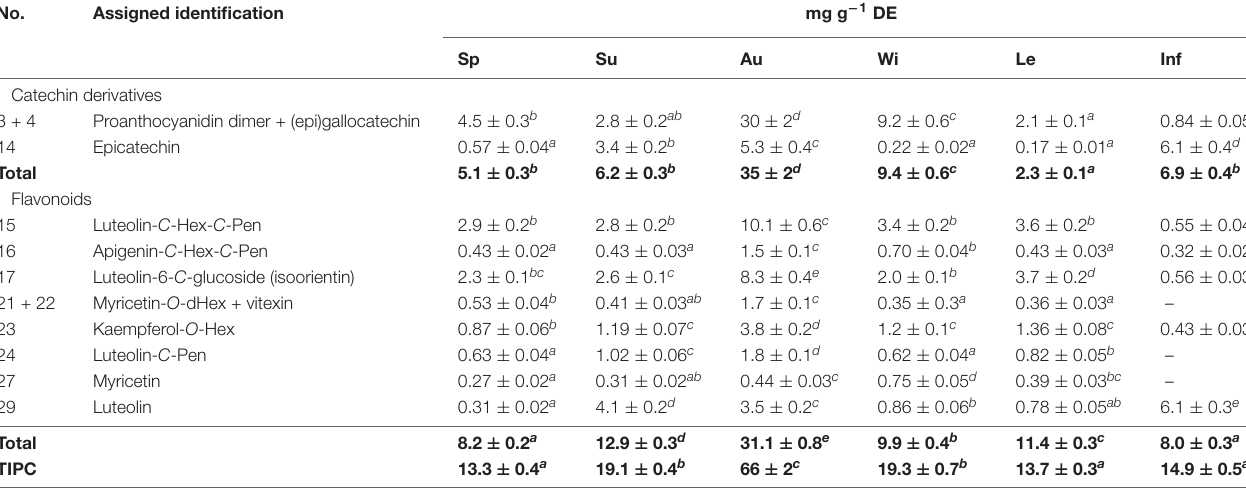
TABLE 4 | Quantification of the main compounds detected in Cladium mariscus (L.) Pohl (sawgrass) before PVPP sample treatment. No.